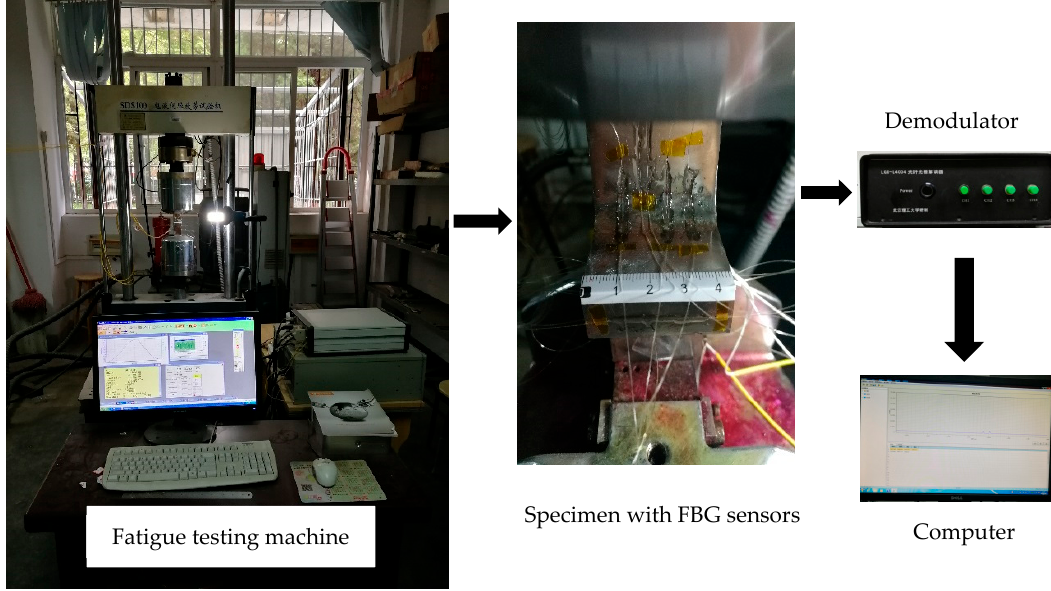
Figure 8. Cyclic strain testing system.